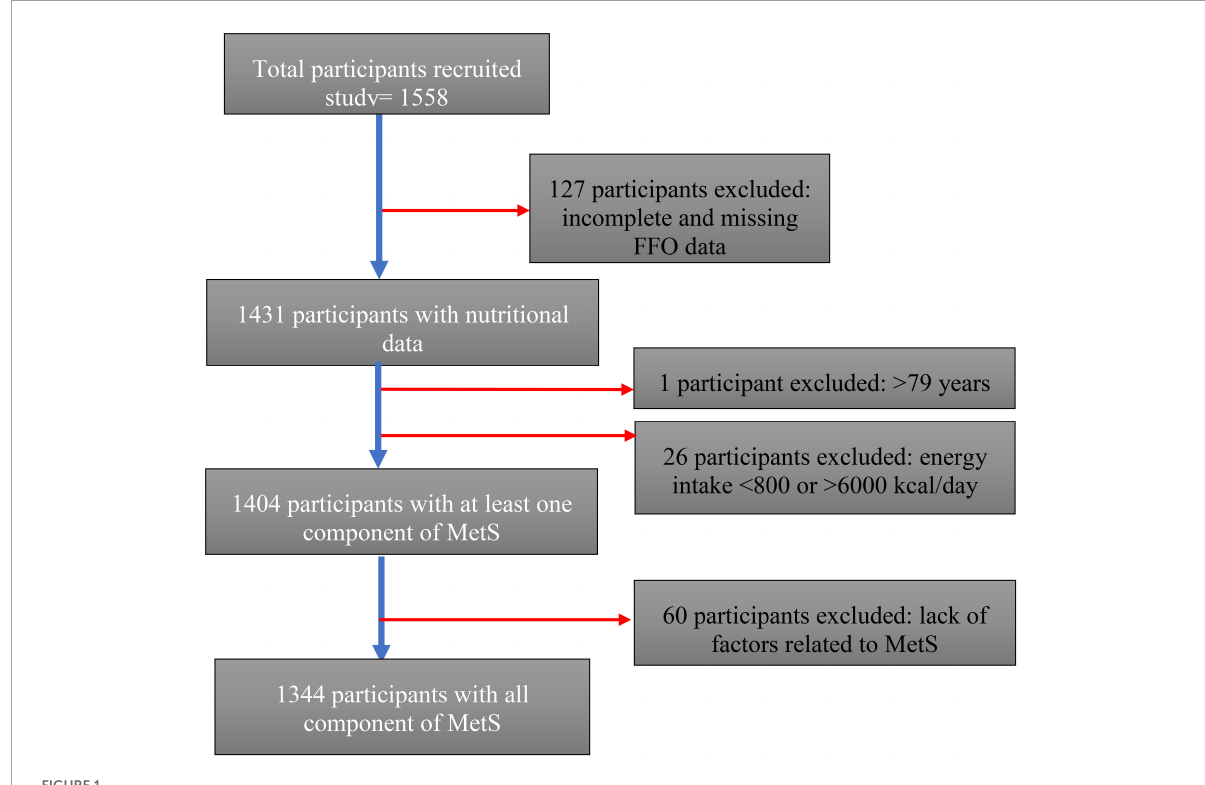
FIGURE1 Participant sample